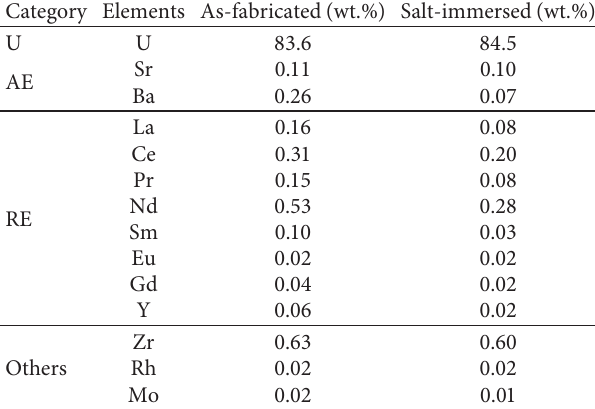
Table 1: ICP-AES analysis of the SSF pellets before and after the immersion in the LKU molten